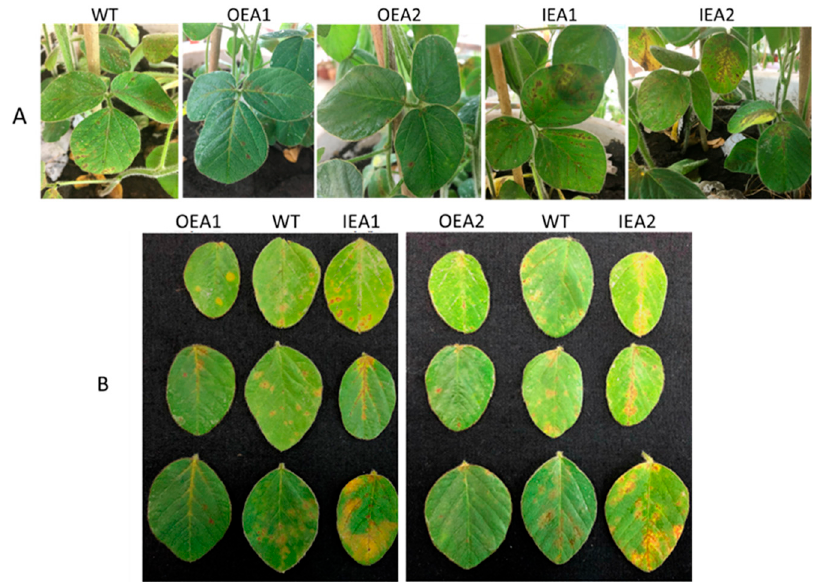
Figure 4. Identi fi cation of Cercospora sojina Hara resistance. ( A ) After 7 days of C. sojina pathogen infection, the untransformed receptor control WT, overexpression line OEA1-OEA2 and plant phe- notype interference expression IEA1-IEA2 with the overall phenotype of plants. ( B ) After 7 days of C. sojina pathogen infection, the untransformed receptor control WT, overexpression line OEA1-OEA2, and leaf phenotype of interference expression IEA1–IEA2.